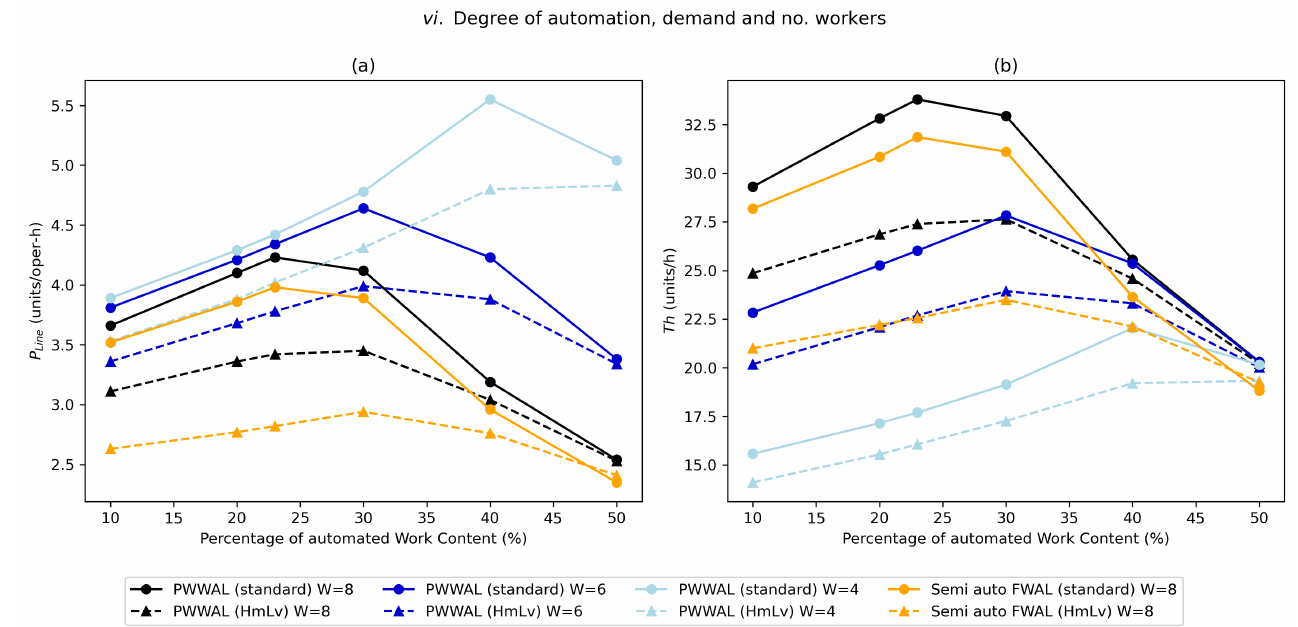
Figure 8. Performance of semiautomated FW and parallel walking-worker line configurations, for different number of manual workers, under standard and high-mix low-volume demand conditions ( scenario v ): ( a ) line productivity ( P Line ), ( b ) throughput ( Th ). Figure 8a shows the assembly line productivity as the degree of automation